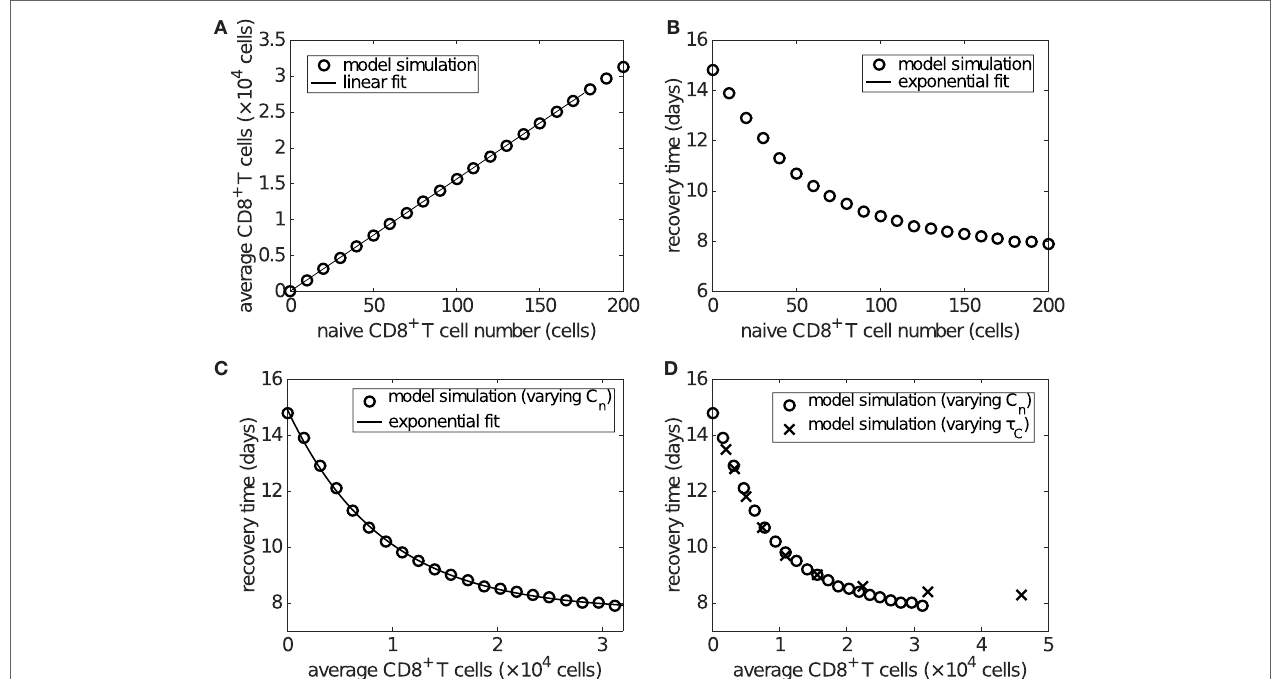
FIGURE 6 | The level of effector CD8 + T cells plays an important role in determining recovery time . Recovery time is defined to be the time when viral load falls to 1 EID 50 /ml. (A) shows that the average effector CD8 + T cell number over days 6–20 is linearly related to the naive CD8 + T cell number (i.e., C n (0)). (B) shows that the recovery time is approximately exponentially related to the initial naive CD8 + T cell number. Combined, these results give (C) , wherein an approximately exponential relationship is observed between the average CD8 + T cell number and recovery time, both of which are experimentally measurable. Note that the exponential/linear fits shown in the figures are not generated by the viral dynamics model but are used to indicate the trends (evident visually) in the model’s behavior. (D) shows that varying the delay τ C (in a similar way to that shown in Figure S5 in Supplementary Material), rather than the naive CD8 + T cell number, does not alter the exponential relationship. In (D) , the crosses represent the results of varying τ C and the empty circles are the same as those in (C) for comparison.